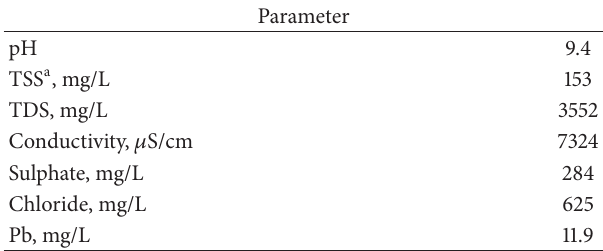
Table 1: Wastewater